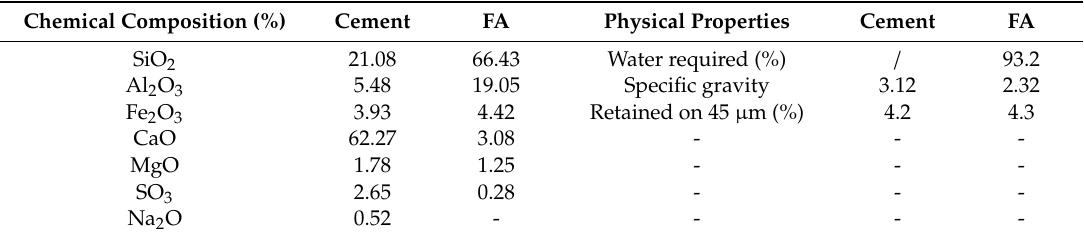
Table 1. Chemical and physical properties of cement and fly ash